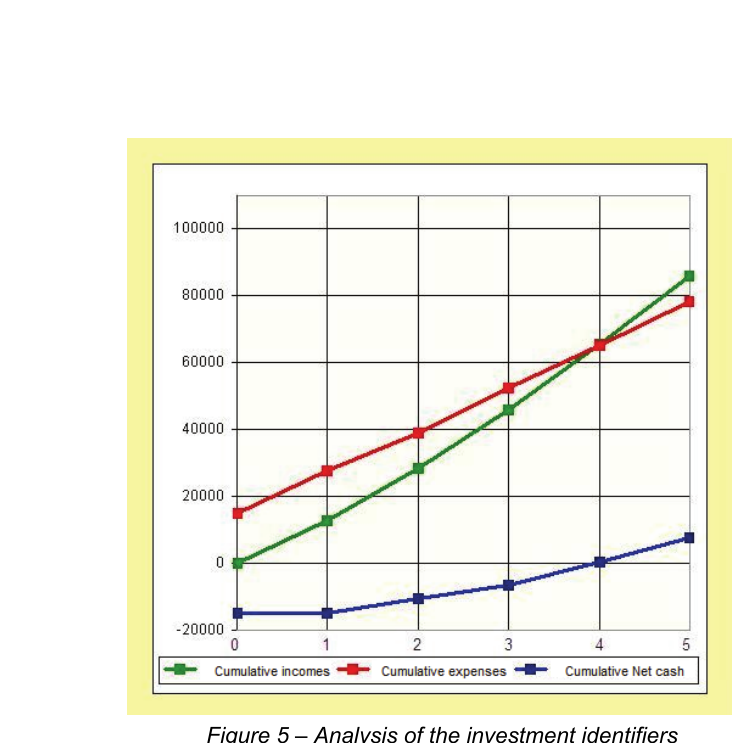
Figure 5 – Analysis of the investment identifiers Рис . 5 – Анализ инвестиционных показателей Слика 5 – Анализа инвестиционих